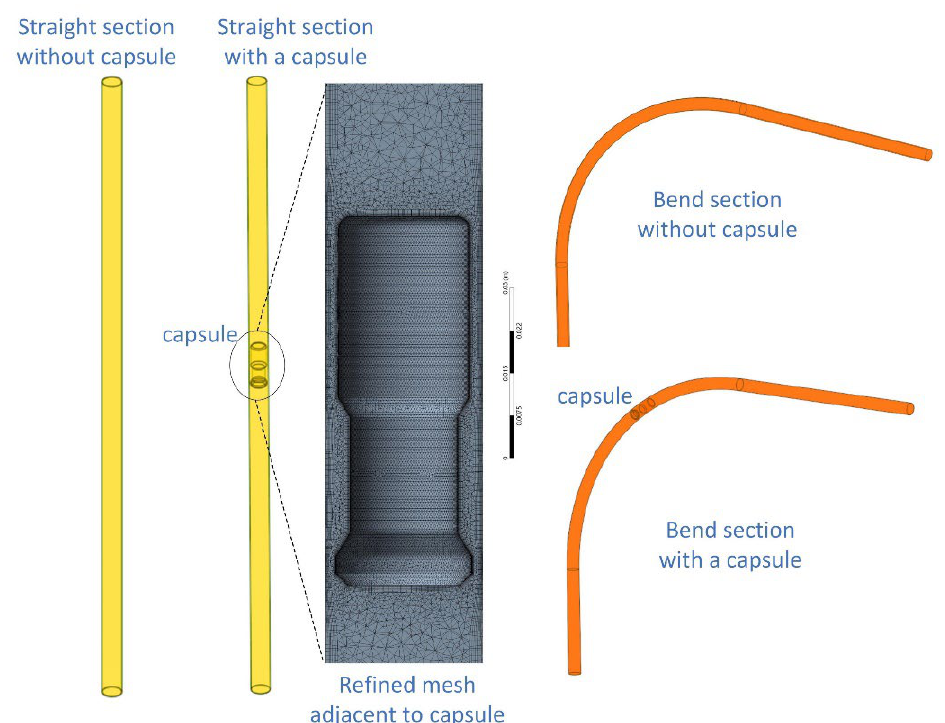
Figure 4. Illustration of the models in 3D CFD simulation.